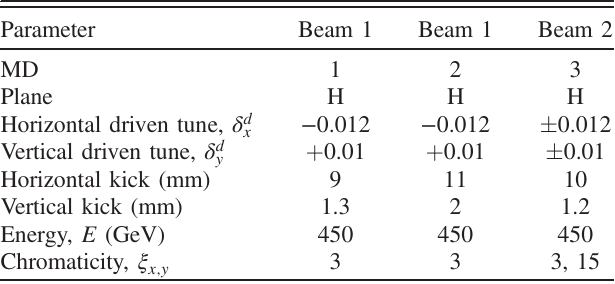
TABLE II. ac dipole and beam settings for the aperture measurements performed at the injection energy of 450 GeV and optics. The horizontal and vertical kicks are computed at a location with a β function of about 180